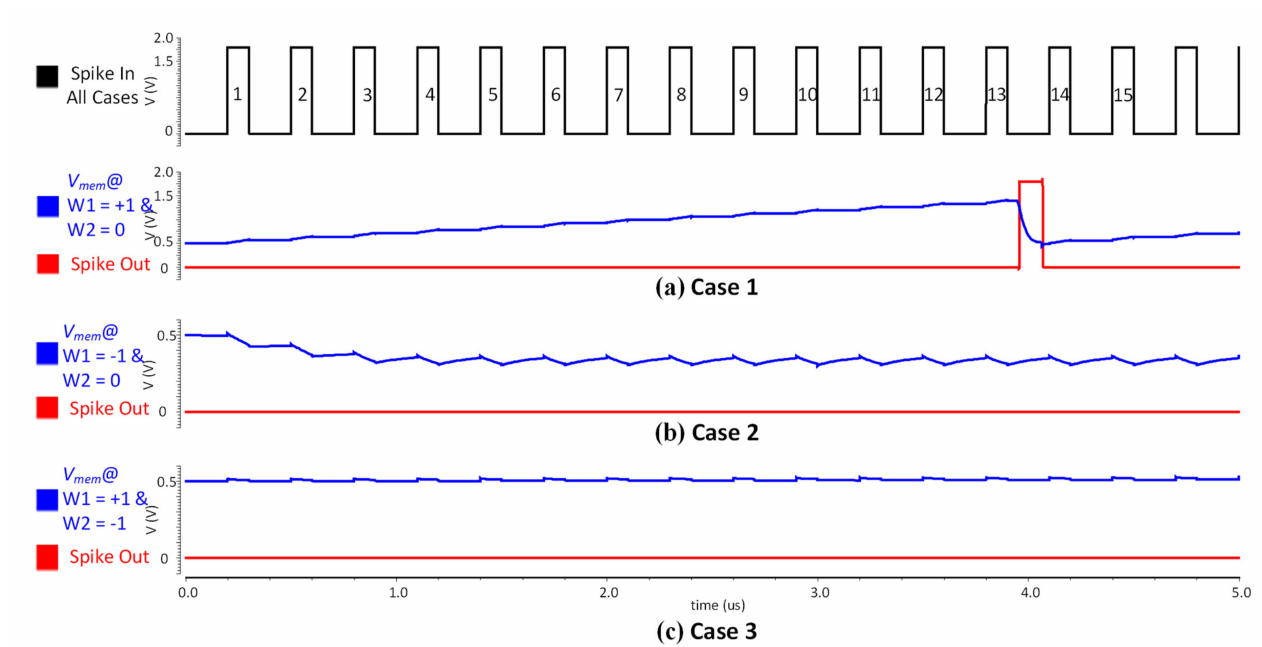
Figure 7. Circuit simulations for a neuron cell (one neuron connected to two synapses) where 15 input spikes are same for all the three cases: ( a ) shows Vmem and an output spike when weight values are W1 = +1 and W2 = 0; ( b ) shows Vmem and spike-out when weight values are W1 = − 1 and W2 = 0; ( c ) shows Vmem and spike-out when weight values are W1 = +1 and W2 = −